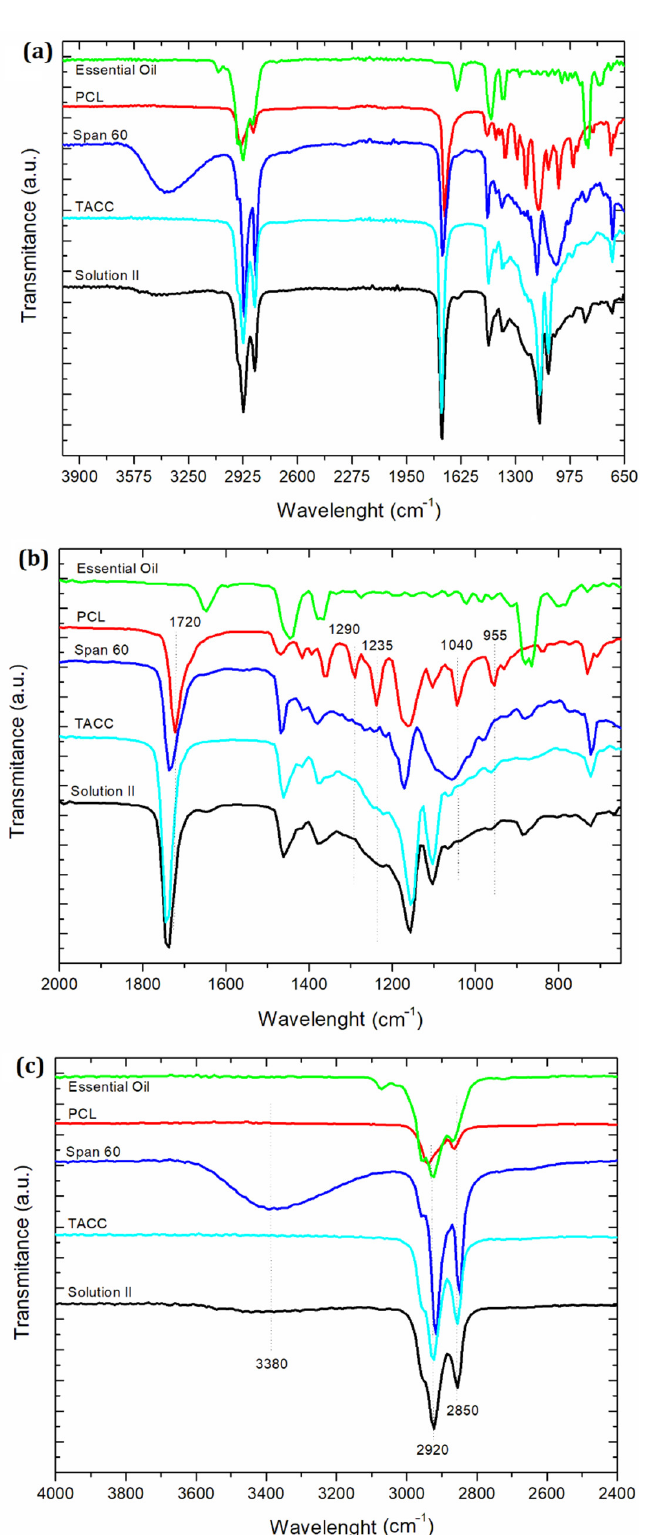
Figure 8. ATR-FTIR spectra of the in natura essential oil, PCL, span 60, TACC, and solution II ( a ) from 4000–650 cm −1 , ( b ) from 2000–650 cm −1 and ( c ) from 4000–2400 cm −1 .